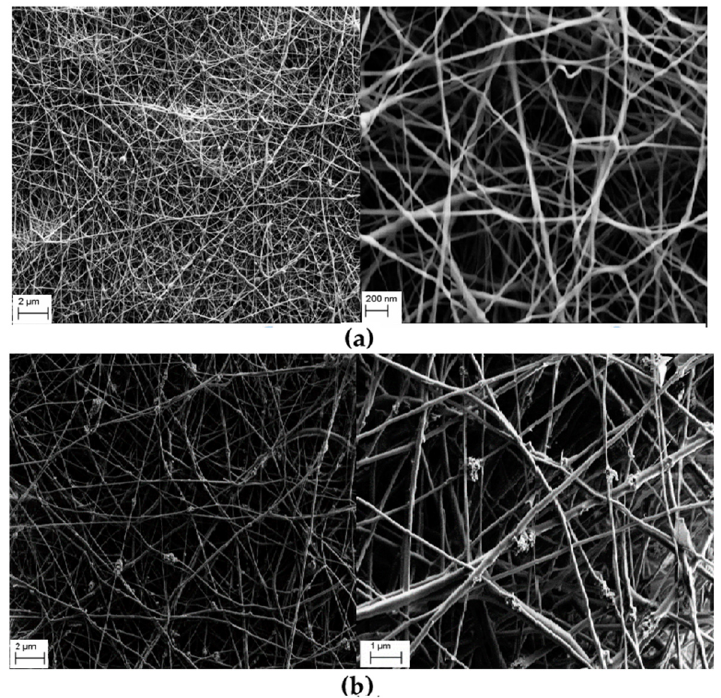
Figure 2. SEM images of ( a ) PA6 NFs and ( b ) NFs of PA6 with 25 wt.% TiO 2 nanoparticles. (Reprinted from the work of Blanco et al. [25]).